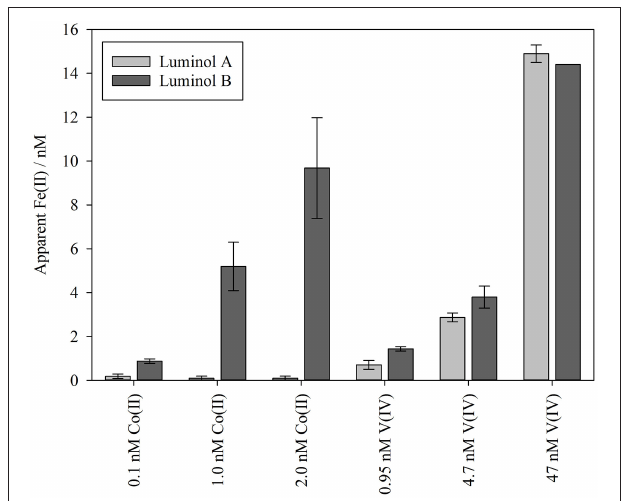
FIGURE 2 | The maximum possible Fe(II) concentration attributable to interference from Co(II) and V(IV) spikes added to Mediterranean seawater. This was calculated by deducting the pre-spike measurement of Fe(II) concentration from the highest post-spike apparent Fe(II) measurement after adding spikes of Co(II) or V(IV). The 14.4nM apparent Fe(II) peak from 47nM V(IV) was above the calibrated range (up to 12nM) of the luminol B